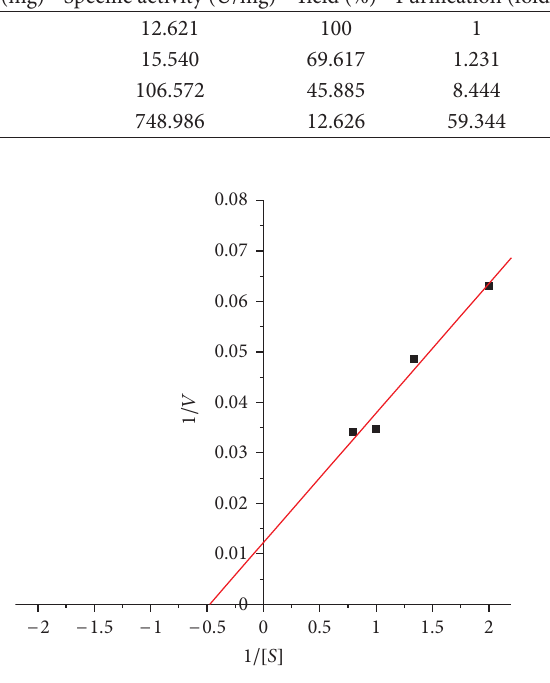
-amylase enzyme 𝛼𝛼